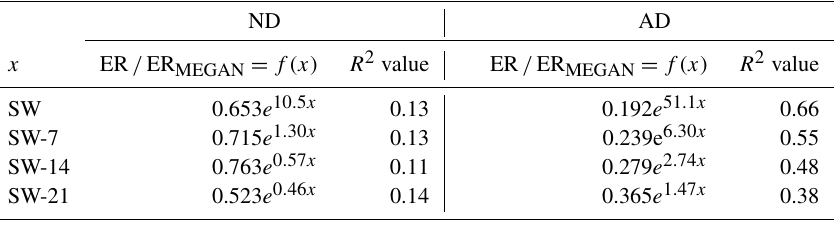
Table 1. Correlations between ER MEGAN / ER and the soil water content (SW) cumulated over 7 to 21 days before the measurement. ER MEGAN and ER are isoprene emission rates calculated using MEGAN2.1 (Guenther et al., 2012) and measured (this study) respectively.